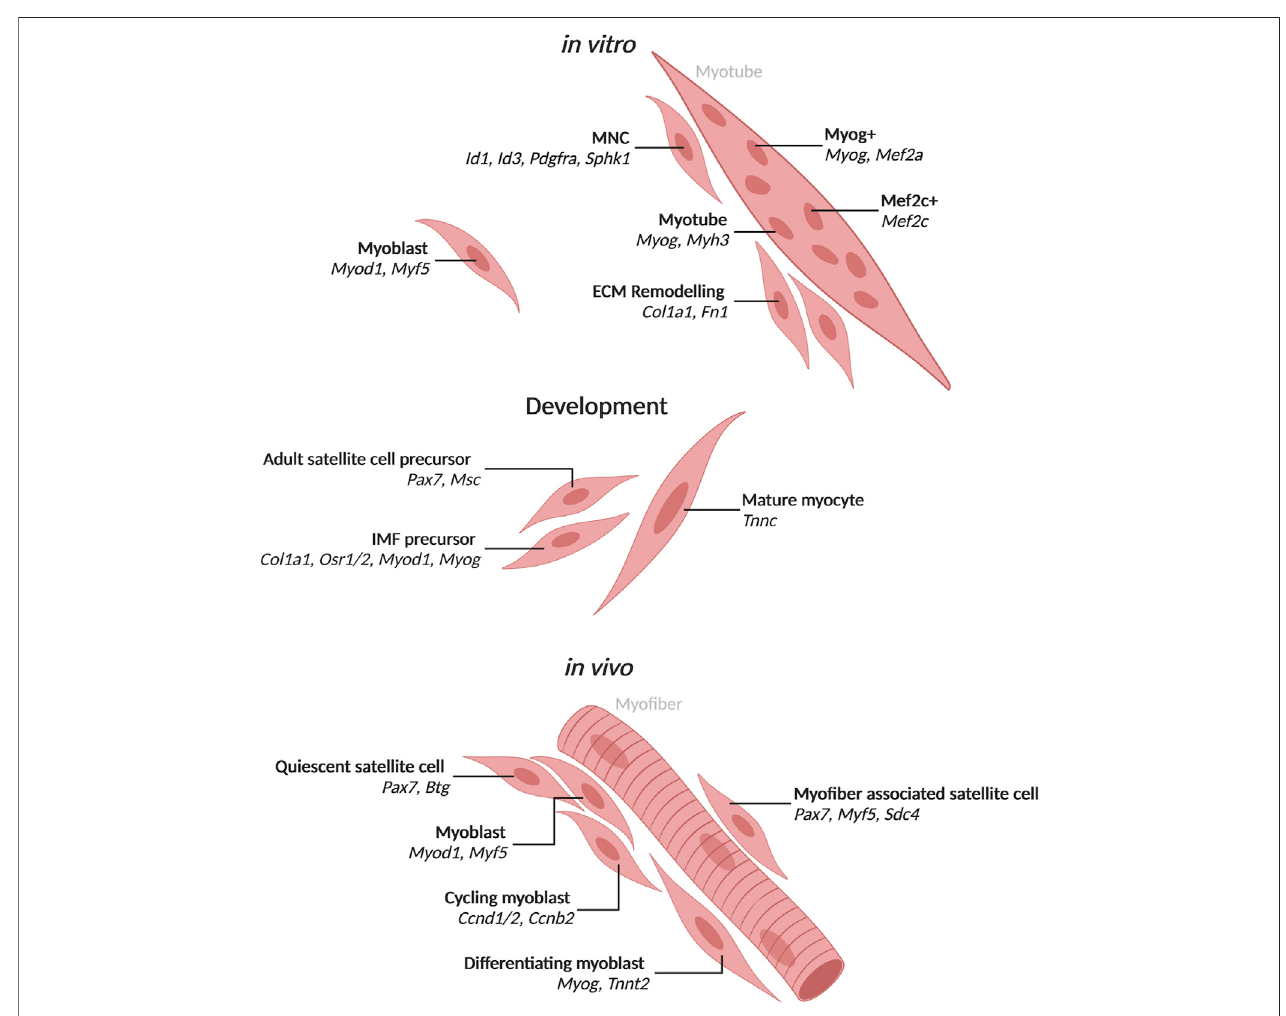
FIGURE 1 | Populations of mononuclear skeletal muscle cells and myotube nuclei with associated markers identi fi ed by single-cell and single-nucleus RNA-seq Populations and top markers of cells and nuclei from mononucleated cells or myotubes. In vitro populations include cell and nuclear populations identi fi ed from in vitro culture of biopsy derived cells or muscle cell lines. Development populations include those observed during development in mice. In vivo populations include those observed in human or mouse muscle. Created with BioRender.com.